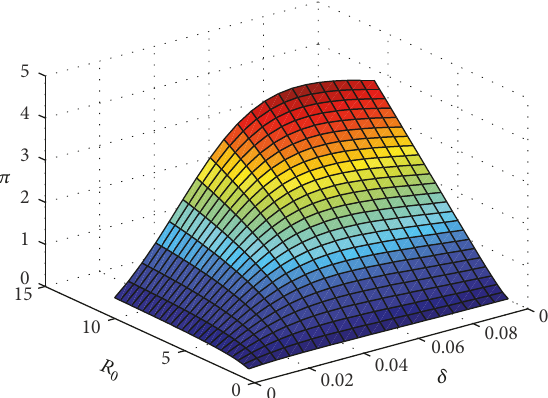
Figure 7: Variation of the current economic burden with respect to discounting force interest, 𝛿 , and basic reproduction number, 𝑅 0